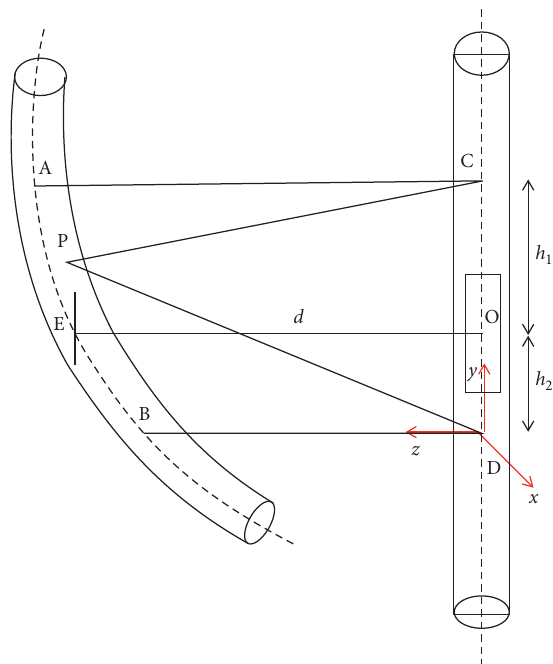
Figure 2: Calculation model of the magnetic